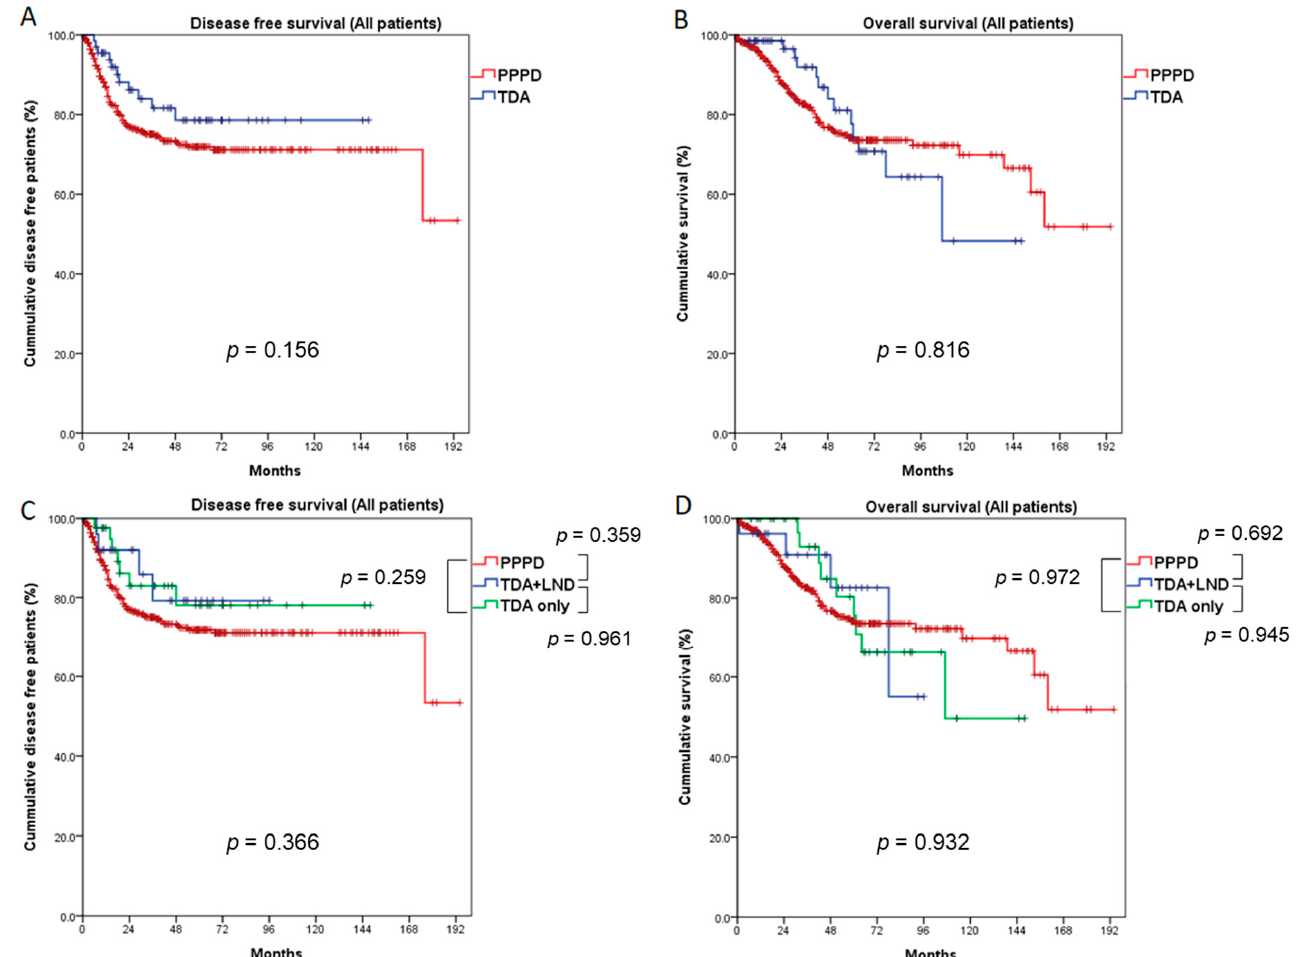
Figure 2. Comparison of survival outcomes between the PPPD and TDA groups (all patients: Tis, T1, and T2). Five-year disease-free survival ( A ) and overall survival ( B ) did not differ between the PPPD and TDA groups. When the TDA group was divided into TDA + LND and TDA-only groups, 5-year disease-free survival ( C ) and overall survival ( D ) did not differ among the three groups. LND: lymph node dissection.